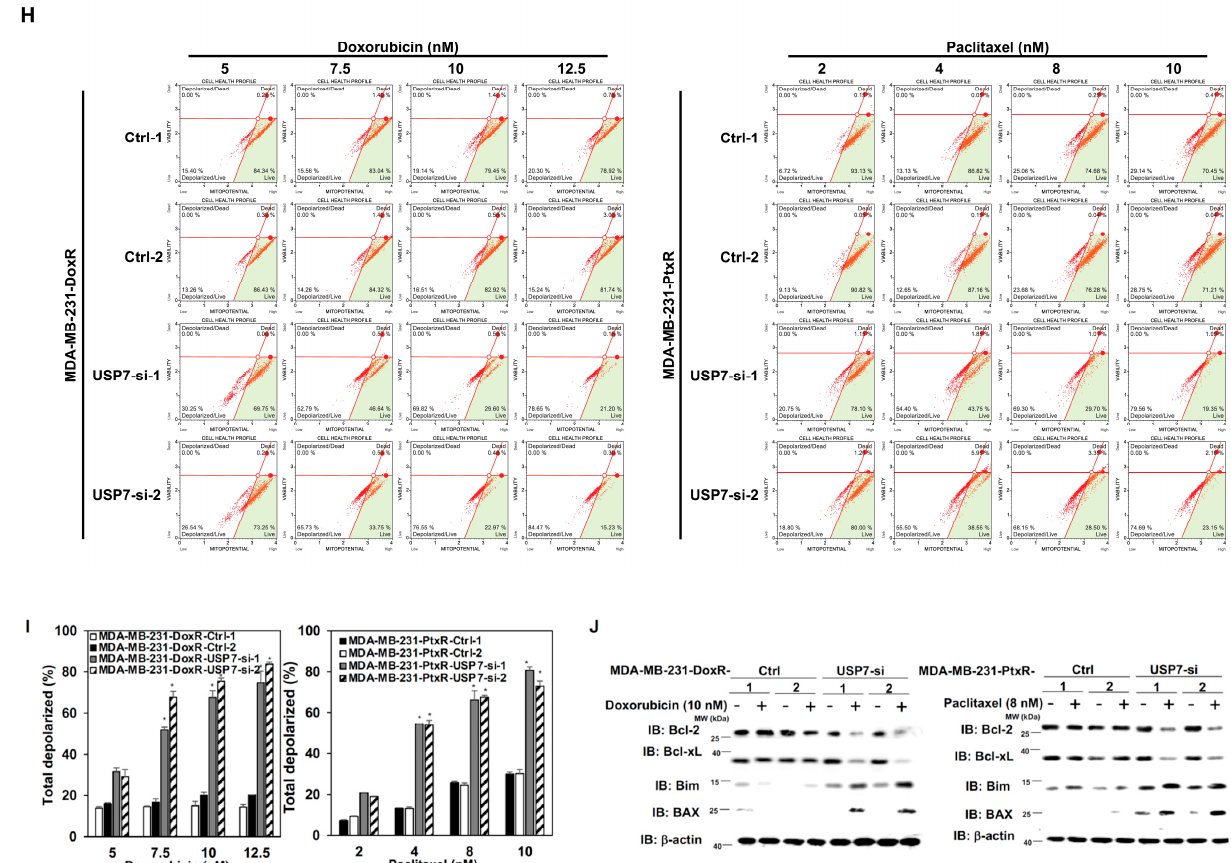
Figure 3. Regulation by USP7 of the chemosensitivity of chemo-drug resistant TNBC. ( A ) Analysis of growth of MDA-MB-231-DoxR-USP7-silencing (upper) and MDA-MB-231-PtxR-USP7-silencing (lower) cells treated with various doses of doxorubicin and paclitaxel, assessed using colony for- mation assays. ( B ) Quantitative analysis for colony formation assays in MDA-MB-231-DoxR (upper) and MDA-MB-231-PtxR (lower) cells with USP7 suppression under treatment of doxorubicin and paclitaxel, respectively. ( C ) Analysis of the viability in MDA-MB-231-DoxR (upper) and MDA-MB- 231-PtxR (lower) cells with USP7 suppression treated with serial doses of doxorubicin and paclitaxel, respectively, performing MTT assays. ( D ) Analysis of the proliferative activity of MDA- MB-231-DoxR (upper) and MDA-MB-231-PtxR (lower) cells with USP7 suppression treated with doxorubicin or paclitaxel for 24, 48, or 72 h, performing MTT assays. (E ) Analysis of apoptosis in MDA-MB-231-DoxR (left) and MDA-MB-231-PtxR (right) cells with USP7 suppression treated with serial doses of doxorubicin or paclitaxel, assessed by Annexin V-dependent flow cytometry assays. ( F ) Quantitative analysis of apoptotic levels of serial doses of doxorubicin-treated MDA-MB-231- DoxR (left) and paclitaxel-treated MDA-MB-231-PtxR (right) with USP7 suppression. ( G ) Protein levels of cleaved caspase family members in MDA-MB-231-DoxR (left) and MDA-MB-231-PtxR (right) cells with USP7 suppression, treated with serial doses of doxorubicin or paclitaxel, assessed by western blot analysis using specific antibodies. ( H ) Analysis of MMP for MDA-MB-231-DoxR (left) and MDA-MB-231-PtxR (right) cells with USP7 suppression, treated with serial doses of dox- orubicin or paclitaxel, assessed using flow cytometry assays. ( I ) Quantitative analysis for total de- polarized levels of MMP in MDA-MB-231-DoxR (left) and MDA-MB-231-PtxR (right) with USP7 suppression under treatment of serial doses of doxorubicin and paclitaxel, respectively. ( J ) Bcl fam- ily member expression in MDA-MB-231-DoxR (left) and MDA-MB-231-PtxR (right) cells with USP7 suppression under treatment of serial doses of doxorubicin or paclitaxel, by western blot analysis with specific antibodies. Data are represented as the mean ± SEM for biological triplicate experi- ments. * p < 0.05, compared with cells with steady concentration of doxorubicin and paclitaxel, re- spectively.